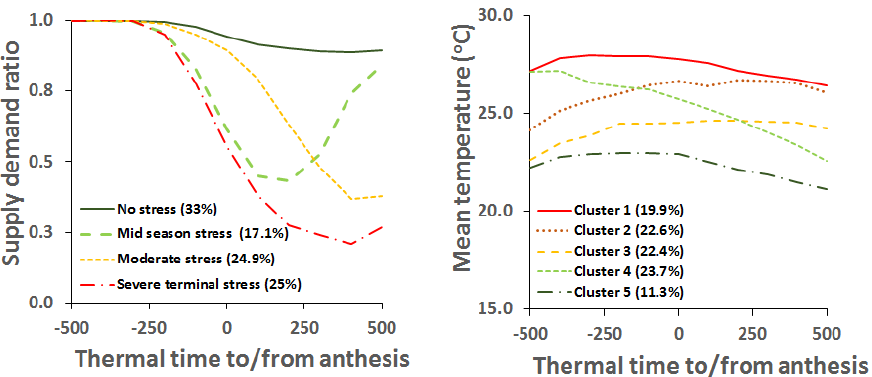
Figure 7. Categories and frequencies of drought ( A ) and thermal regimes ( B ) in the northern grains regions [37]. Major drought stress patterns are no-stress, mid-season stress (mid-seas.), moderate terminal stress (mod-stress), and severe terminal stress (severe-terminal stress) based on APSIM simulated supply demand ratio (SDR) averaged every 100 °Cd. An SDR of one indicates no stress and supply matching the demand and a lower value indicates the supply demand gap. The thermal environments represent mean temperature averaged also for every 100 °Cd. The percent occurrence of occurring different drought and thermal environment types are in inset table of each chart. Inputs used in generating these figures included site specific climatic data for 113 years and soils from 45